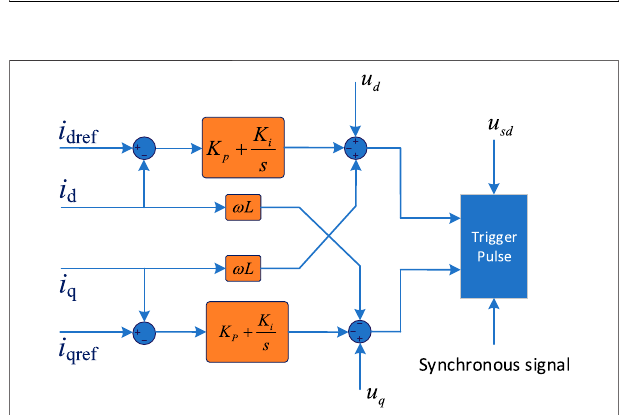
FIGURE 3 | Inner vector current control loop diagram.